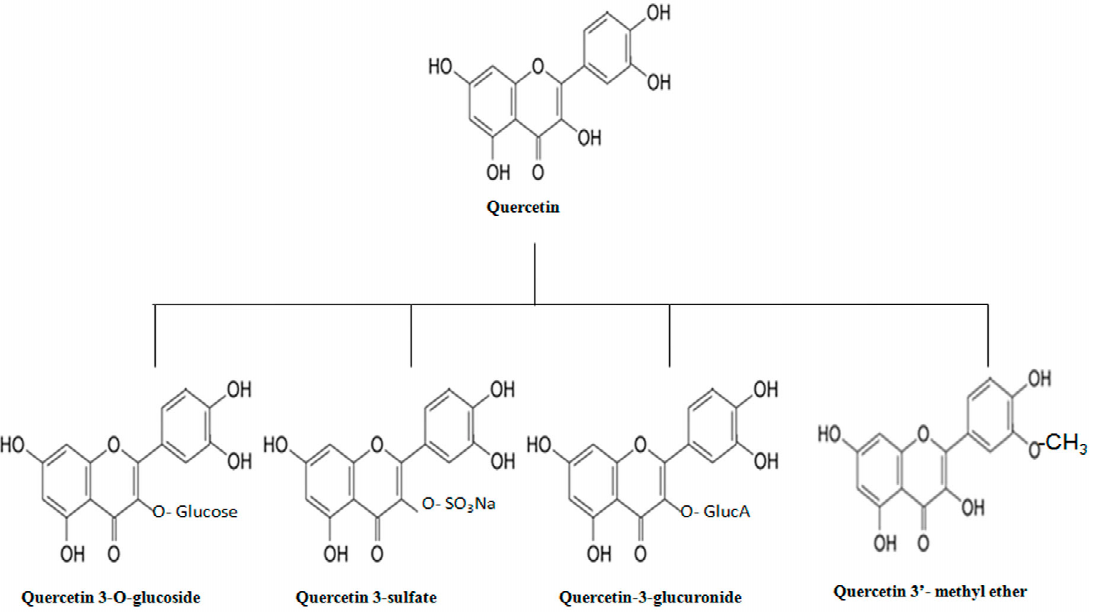
Figure 2. Structure of quercetin and its derivatives.